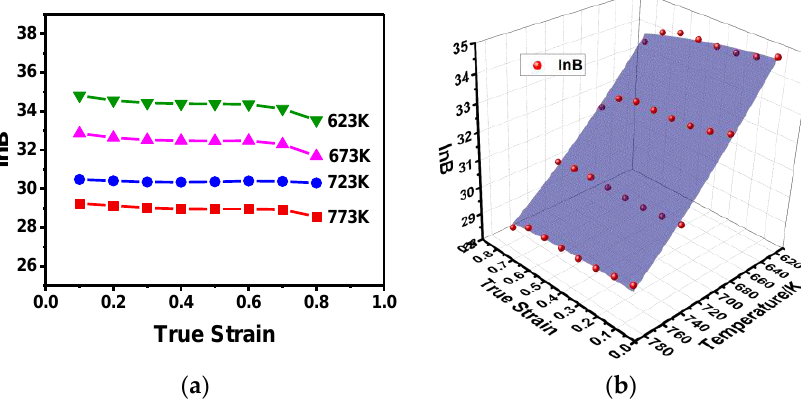
Figure 6. The variation of ln B : ( a ) at different strains and temperatures; ( b ) 3D illustration and its nonlinear surface fitting.